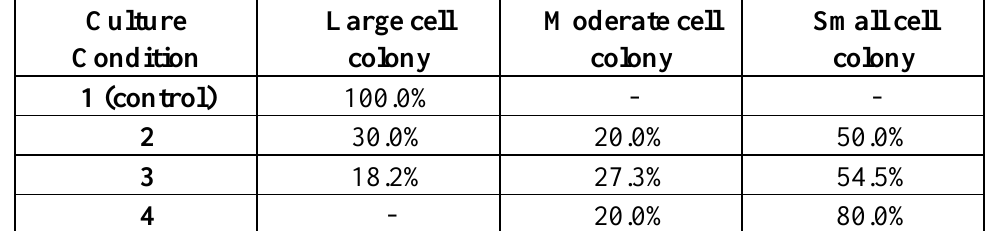
Table 1. Percentage of BT-474 colonies grown on the feeder layer of MCF-10A cells preincubated with pioglitazone and/or serum-rich growth media for 2 weeks. A total of 20 cells/mL of BT-474 was used as the input for all culture conditions. Data were calculated as the % of colony number, according to the size, per total number of colonies formed on the preincubated MCF-10A feeder layer. The experiments were repeated 3 times to confirm reproducibility of the results, and a representative result is shown below.